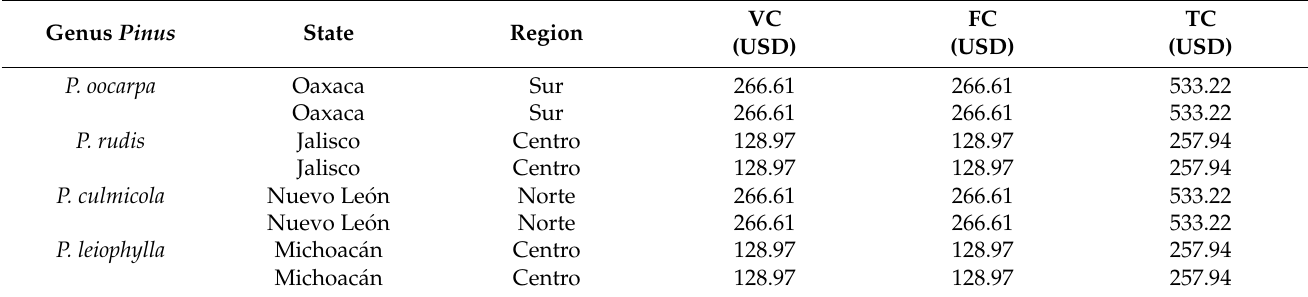
Table 5. Locations of seed collection of populations o the genus Pinus